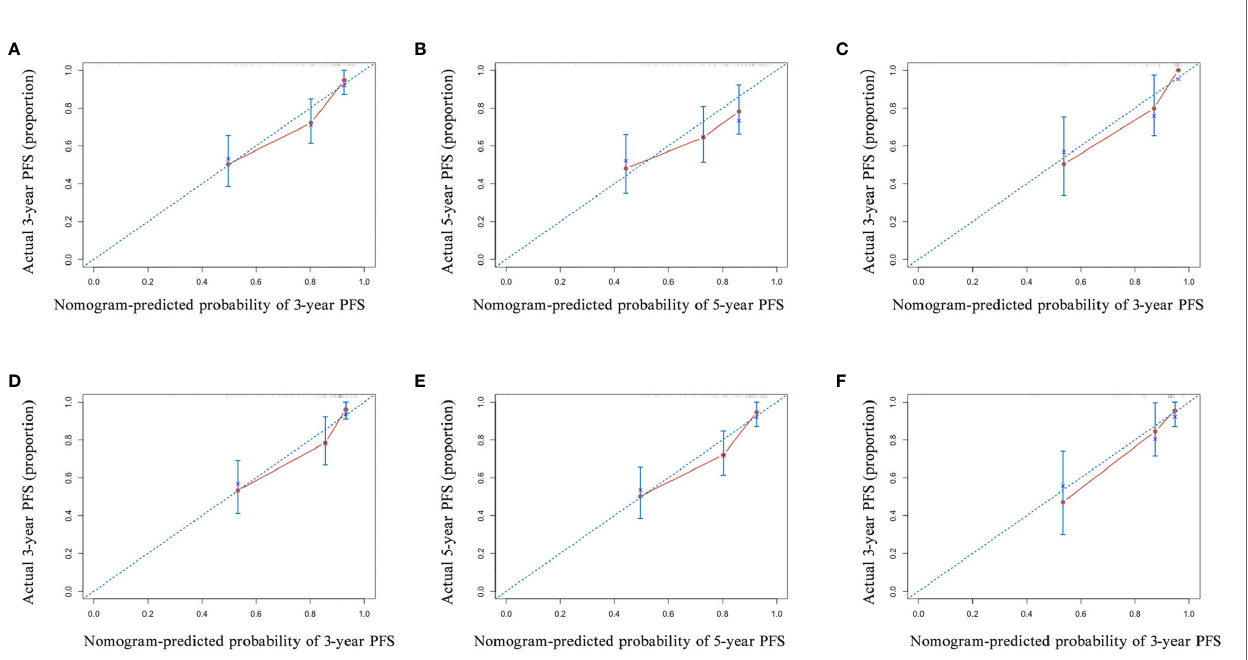
FIGURE 5 | The calibration curve of the nomogram for predicting the progression-free survival (PFS) with pre-neoadjuvant chemotherapy (NACT) or post-NACT EBV DNA levels. (A) 3-year and (B) 5-year in nomogram with pre-NACT EBV DNA levels in the primary cohort and (C) 3-year in the validation cohort; (D) 3-year and (E) 5-year in nomogram with post-NACT EBV DNA levels in the primary cohort and (F) 3-year in the validation cohort. Actual PFS is plotted on the y-axis; nomogram-predicted probability of PFS is plotted on the x-axis.